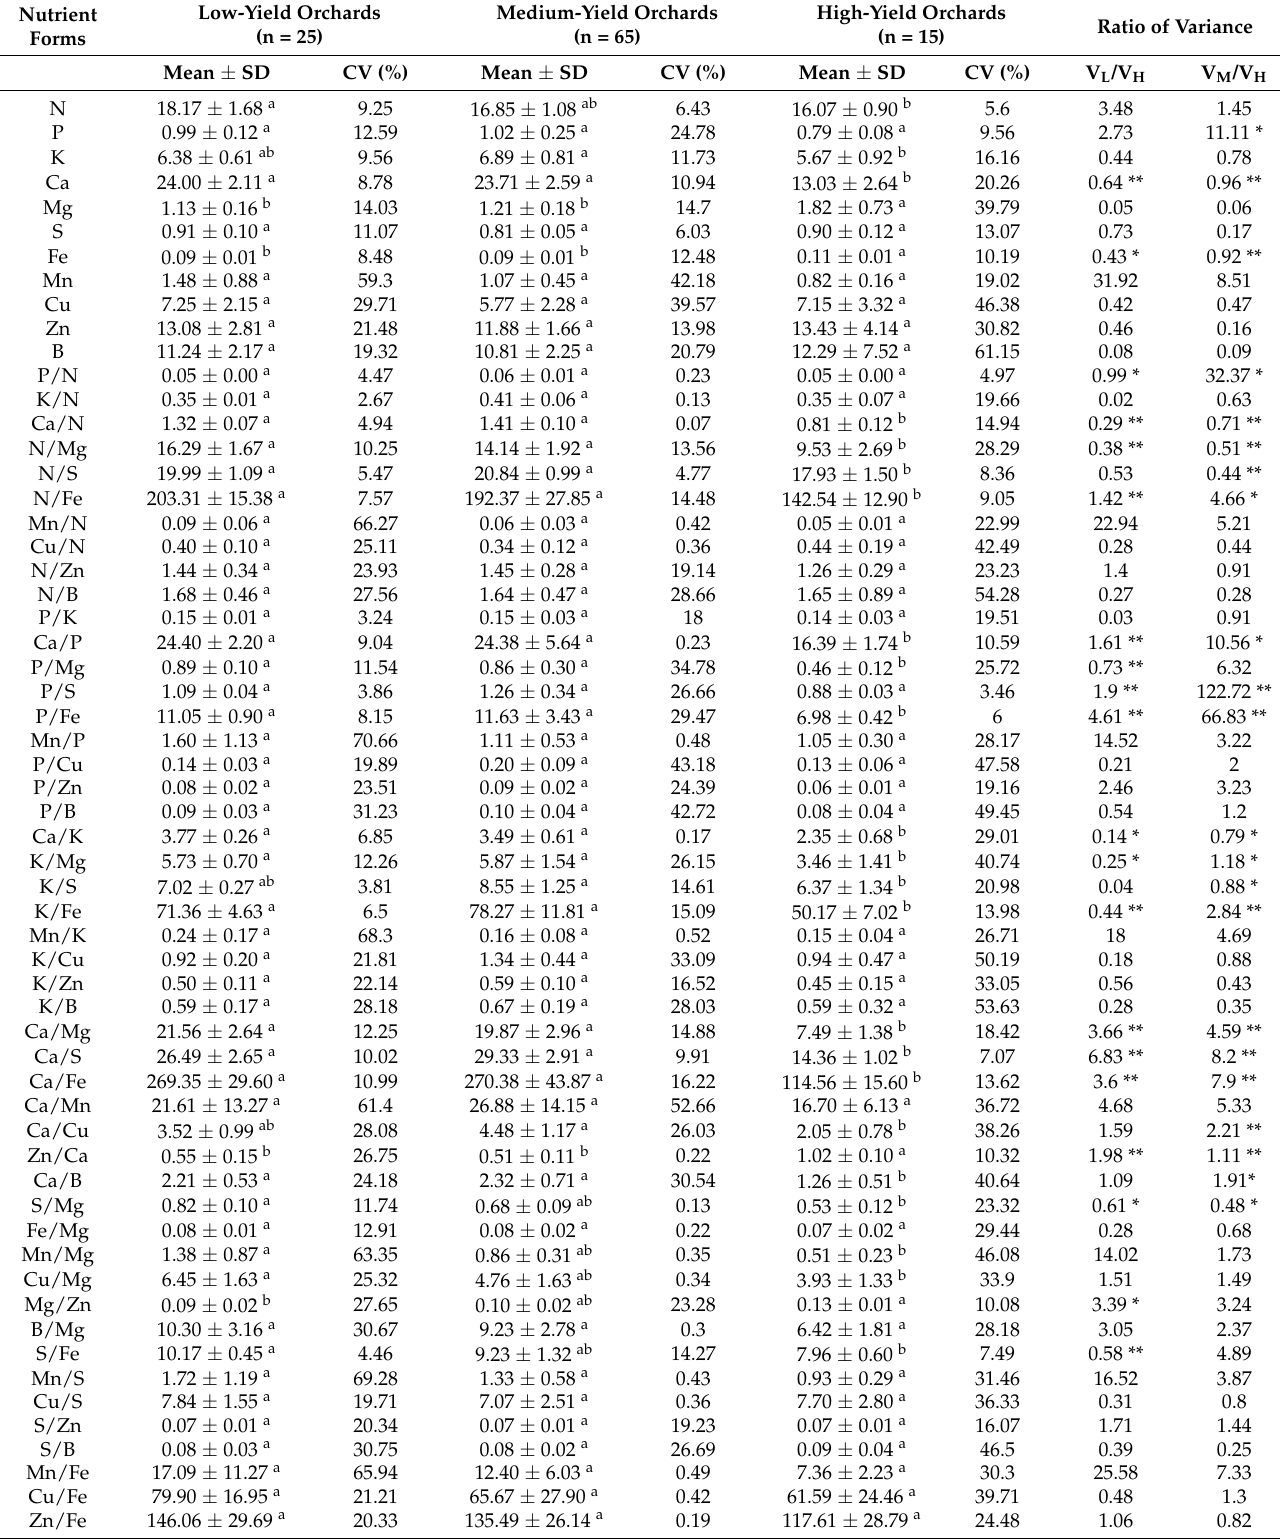
Table 2. The statistics of the Diagnosis and Recommendation Integrated System diagnostic parameters of Tainong